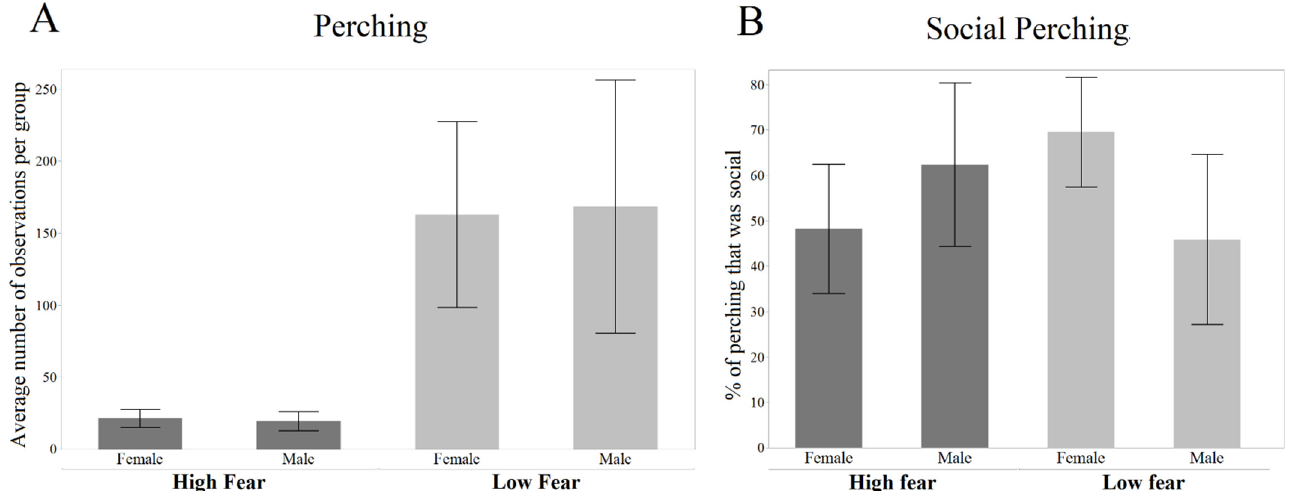
Figure 3. Frequency of perching in total and in a social context (mean ± SE). ( A ) Average number of observations per group of perching. ( B ) Number of observations of a bird perching together with at least one other bird.